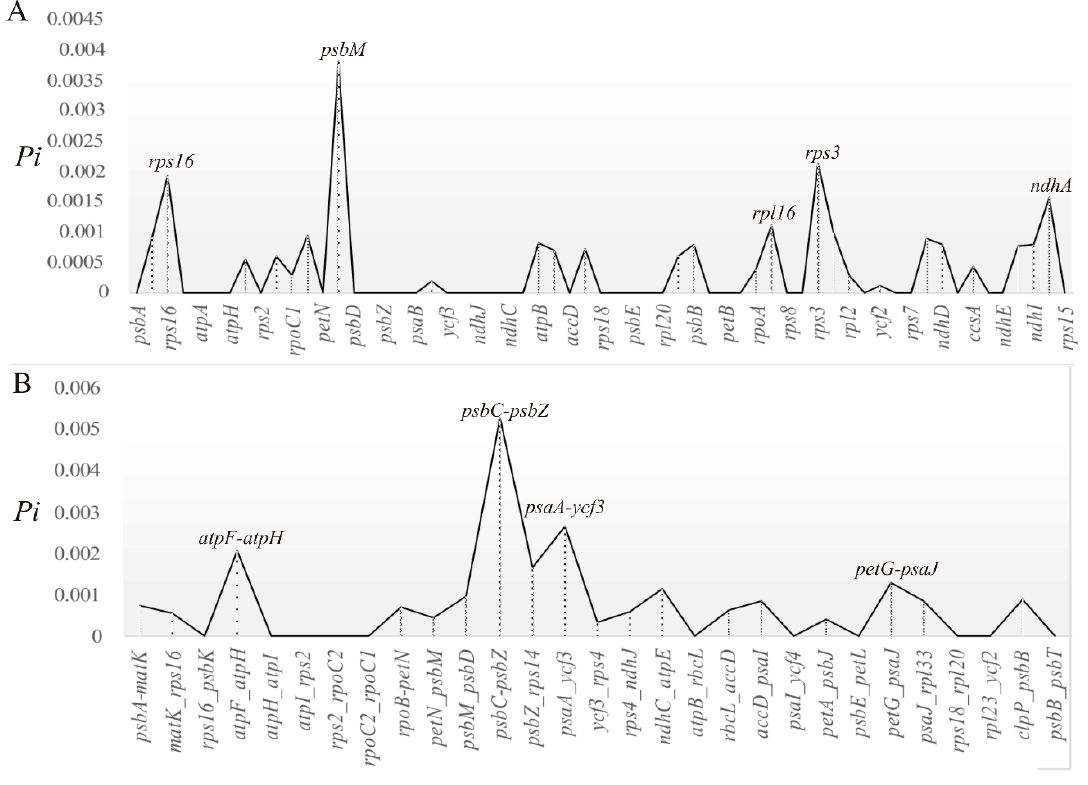
Figure 4. Nucleotide variability ( Pi ) values among chloroplast genomes of the five Str. ionanthus subspecies for ( A ) Coding sequences and ( B ) Intergenic spacer regions.